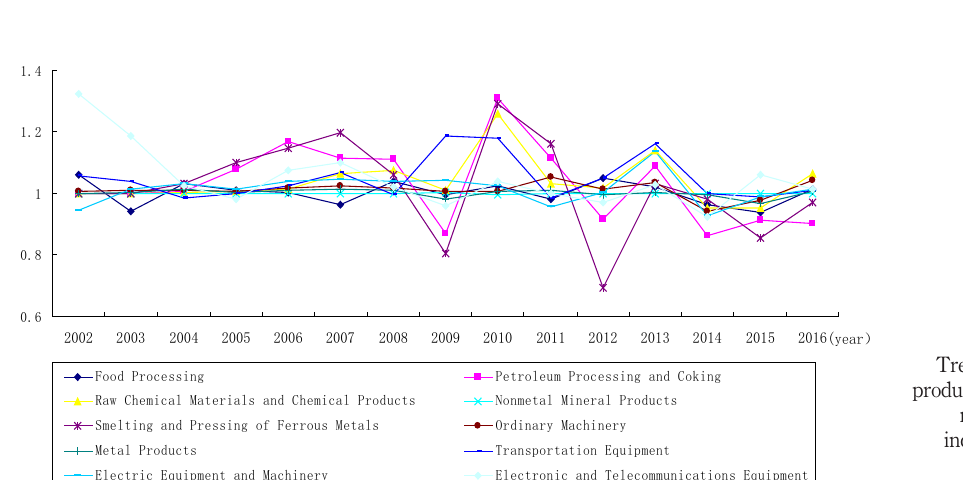
Table 3. Average carbon